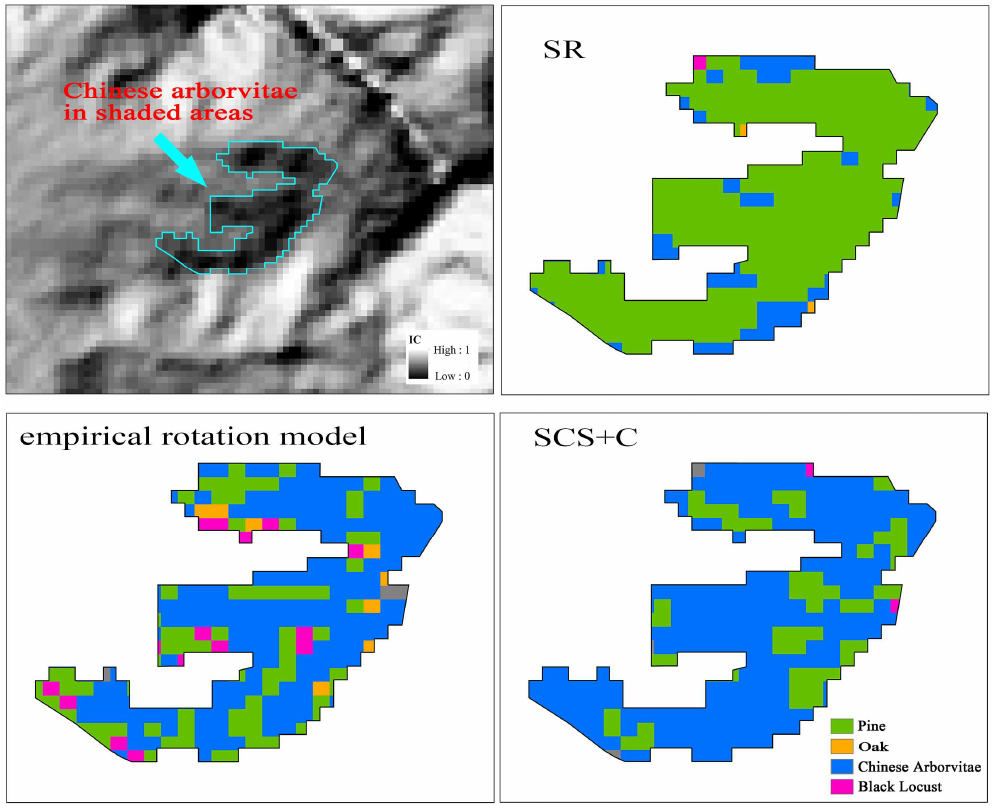
Figure 9. Contrast map of Chinese arborvitae classification in shaded areas by using shadowless training data. SR represents the pre-corrected conditions of the classification result. The model represents the classification result after topographic corrected by the specific model.